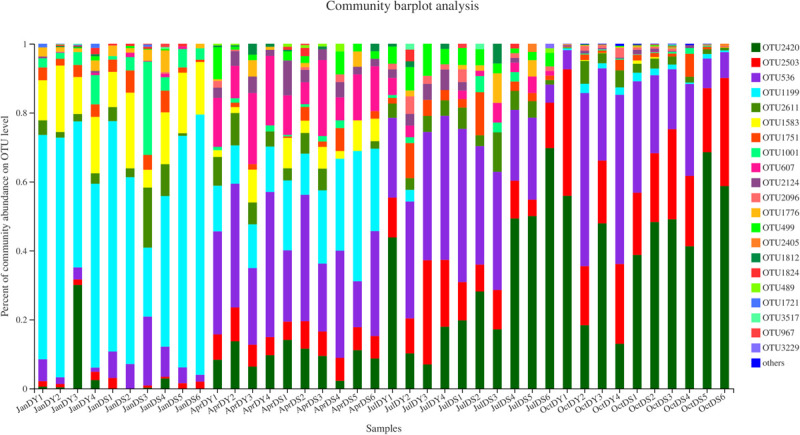
Vibrio community compositions at the species level across all samples.